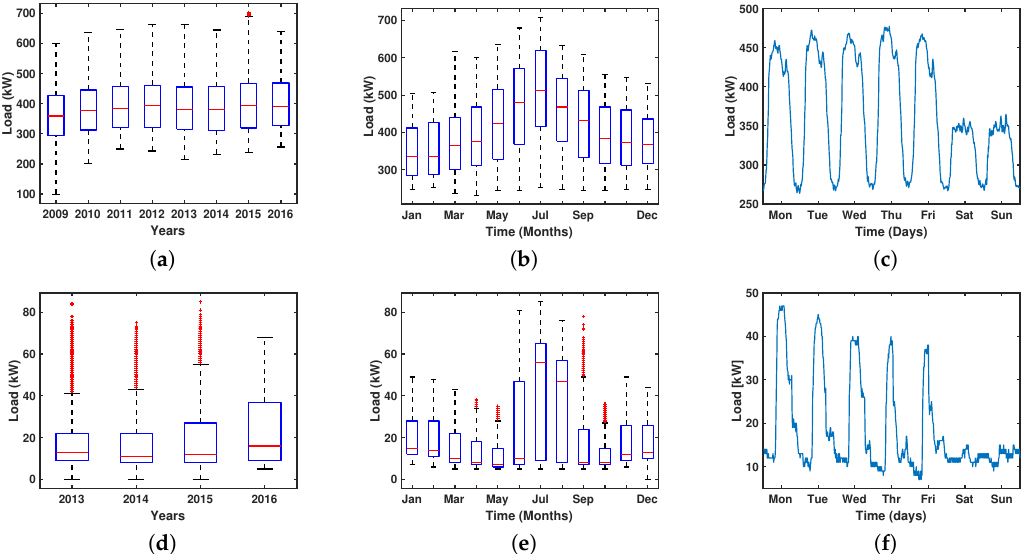
Figure 1. Database representation for the two healthcare buildings, Hospital Universitario de Fuenlabrada (HUF) (up) and Centro de Especialidades El Arroyo (CEA) (down): ( a , d ) electrical load and available data; ( b , e ) yearly load profile example; ( c , f ) weekly load profile